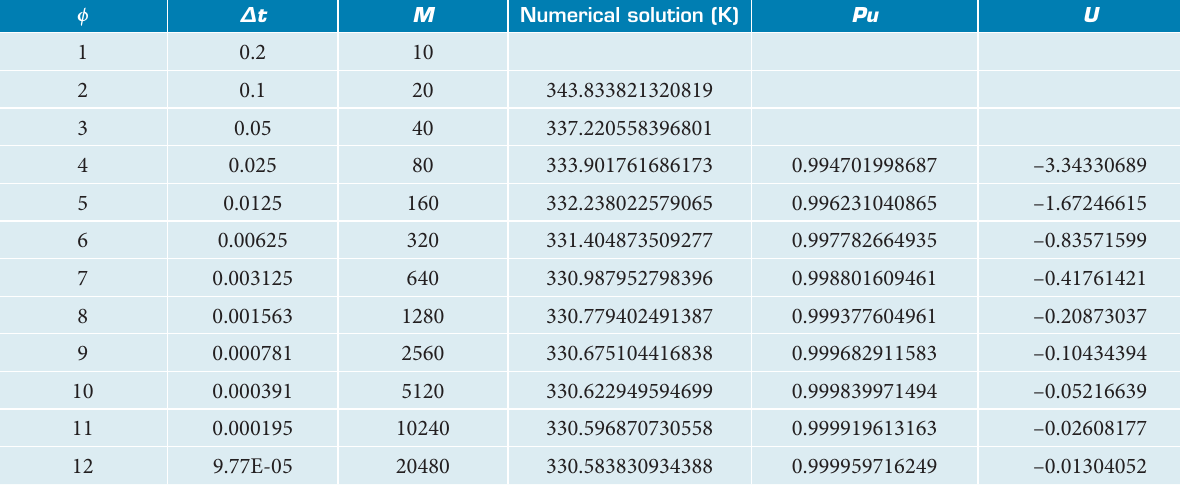
Table 6. Estimative of discretization error ( U ) in the direct problem (D.P.)